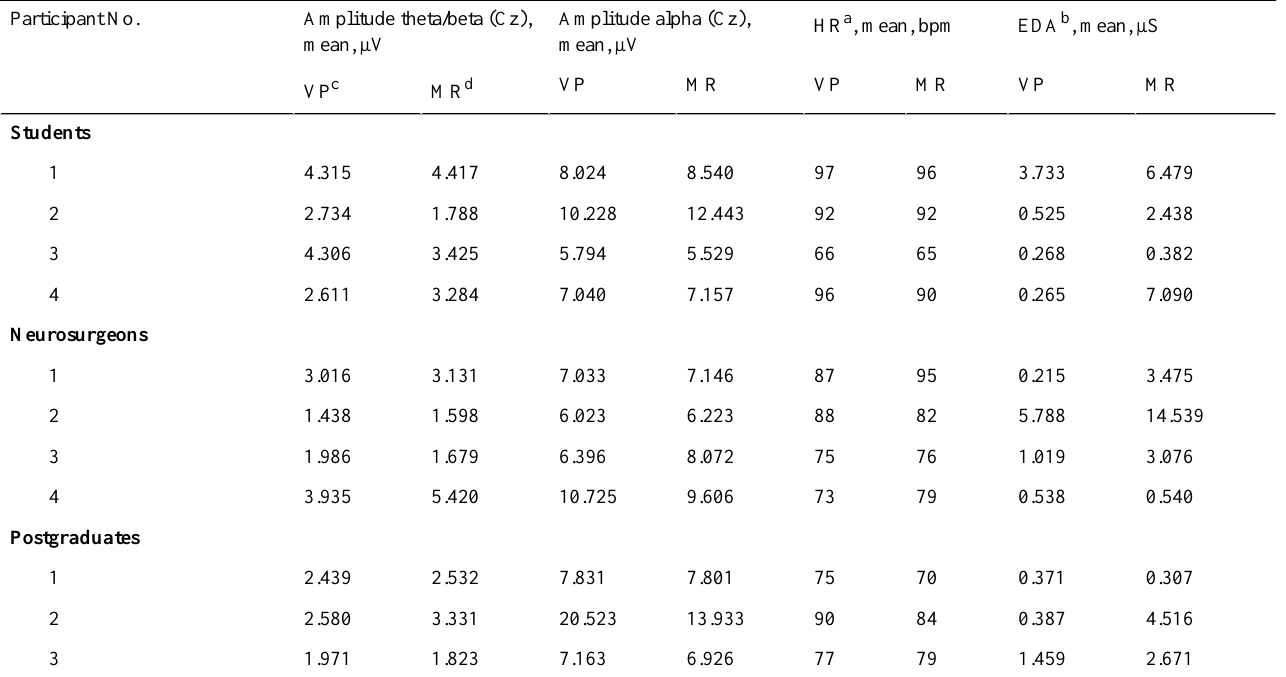
Table 3. Biosignal averages per participant for the virtual reality/mixed reality educational